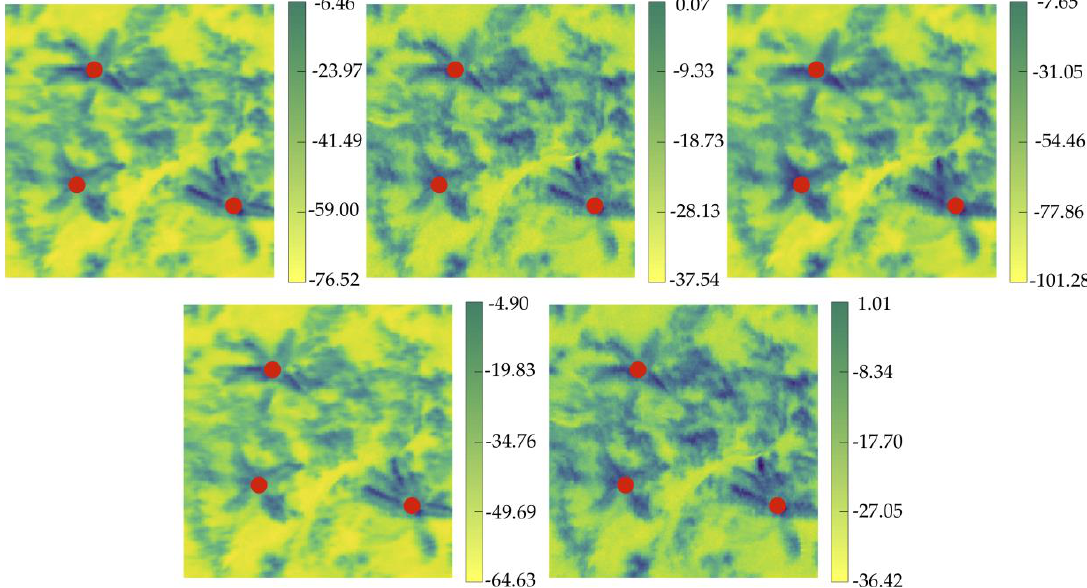
Figure 8. Example of the five linear band combinations obtained by the proposed method.